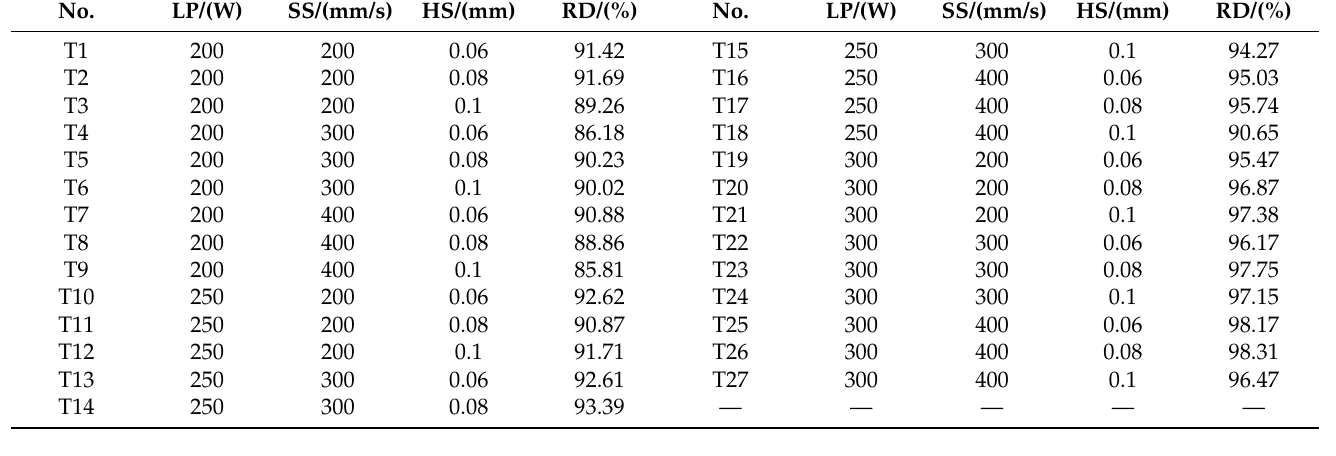
Figure 2. LPBF-processed tungsten samples.